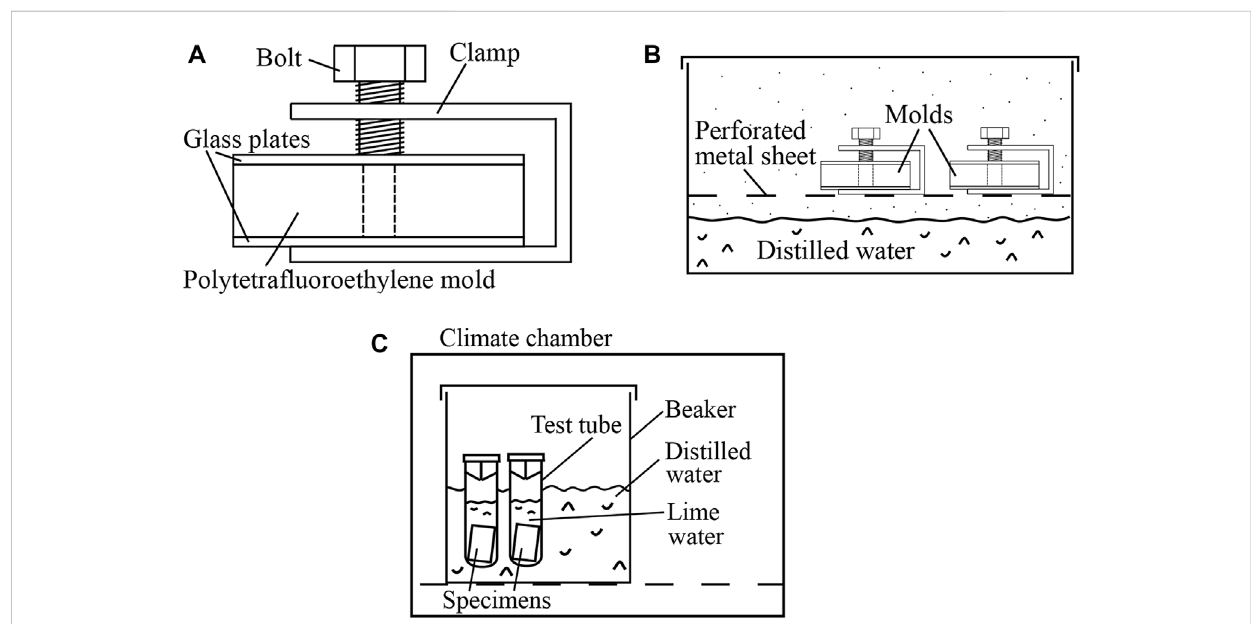
FIGURE 2 (A,B) StorageofspecimensofBiodentineduringtheirtransitionfromamoldablegelintoasolid: (A) specimeninsideapolytetra fl uoroethylenemold, covered by two glass plates which were secured by means of a U-shaped clamp and a screw, (B) the clamped molds were stored above a water bath tempered to 37 ° C. (C) Storage of solid specimens until they were scheduled for destructive compressive strength testing: the specimens were stored in lime-saturated solution inside a temperature-controlled environment.